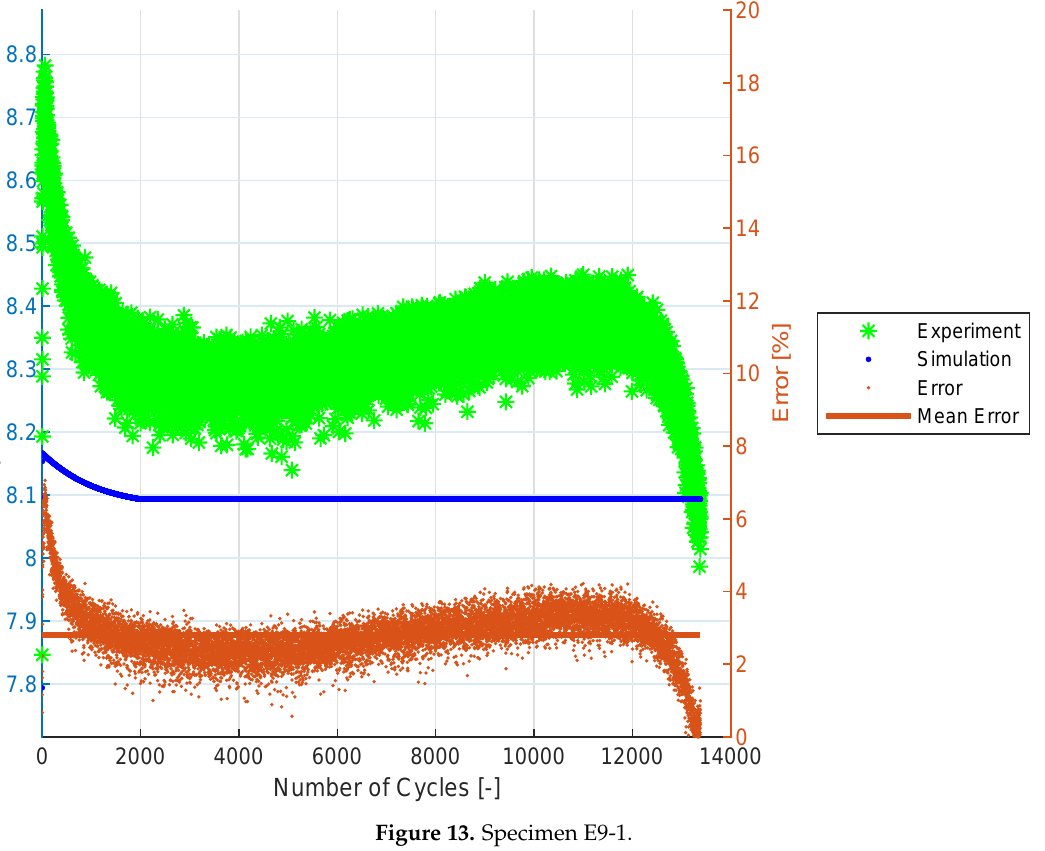
Figure 13. Specimen